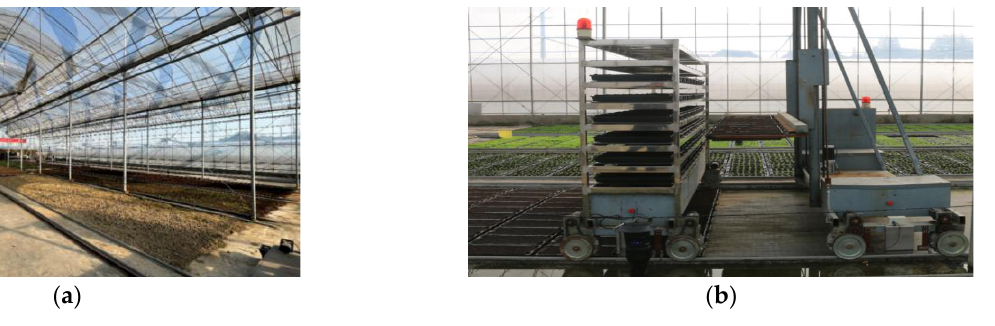
Figure 2. The agricultural robot used in experiment. ( a ) The whole situation of facility factory nursery base. ( b ) 7Y-50 cavity tray intelligent transportation system. base. ( b ) 7Y-50 cavity tray intelligent transportation